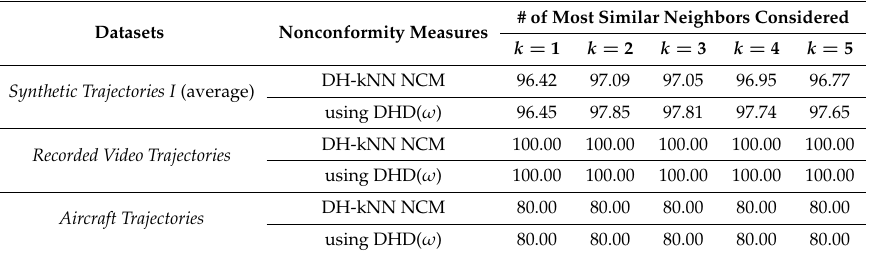
Table 3. Accuracy (%) of anomaly detection on different trajectory